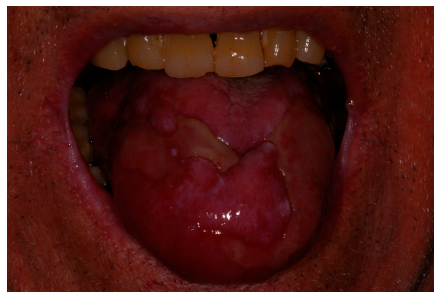
Figure 1. Clinical view of the patient at the first evaluation: tongue ulcerative lesions were making it impossible for the patient feeding with solid food.